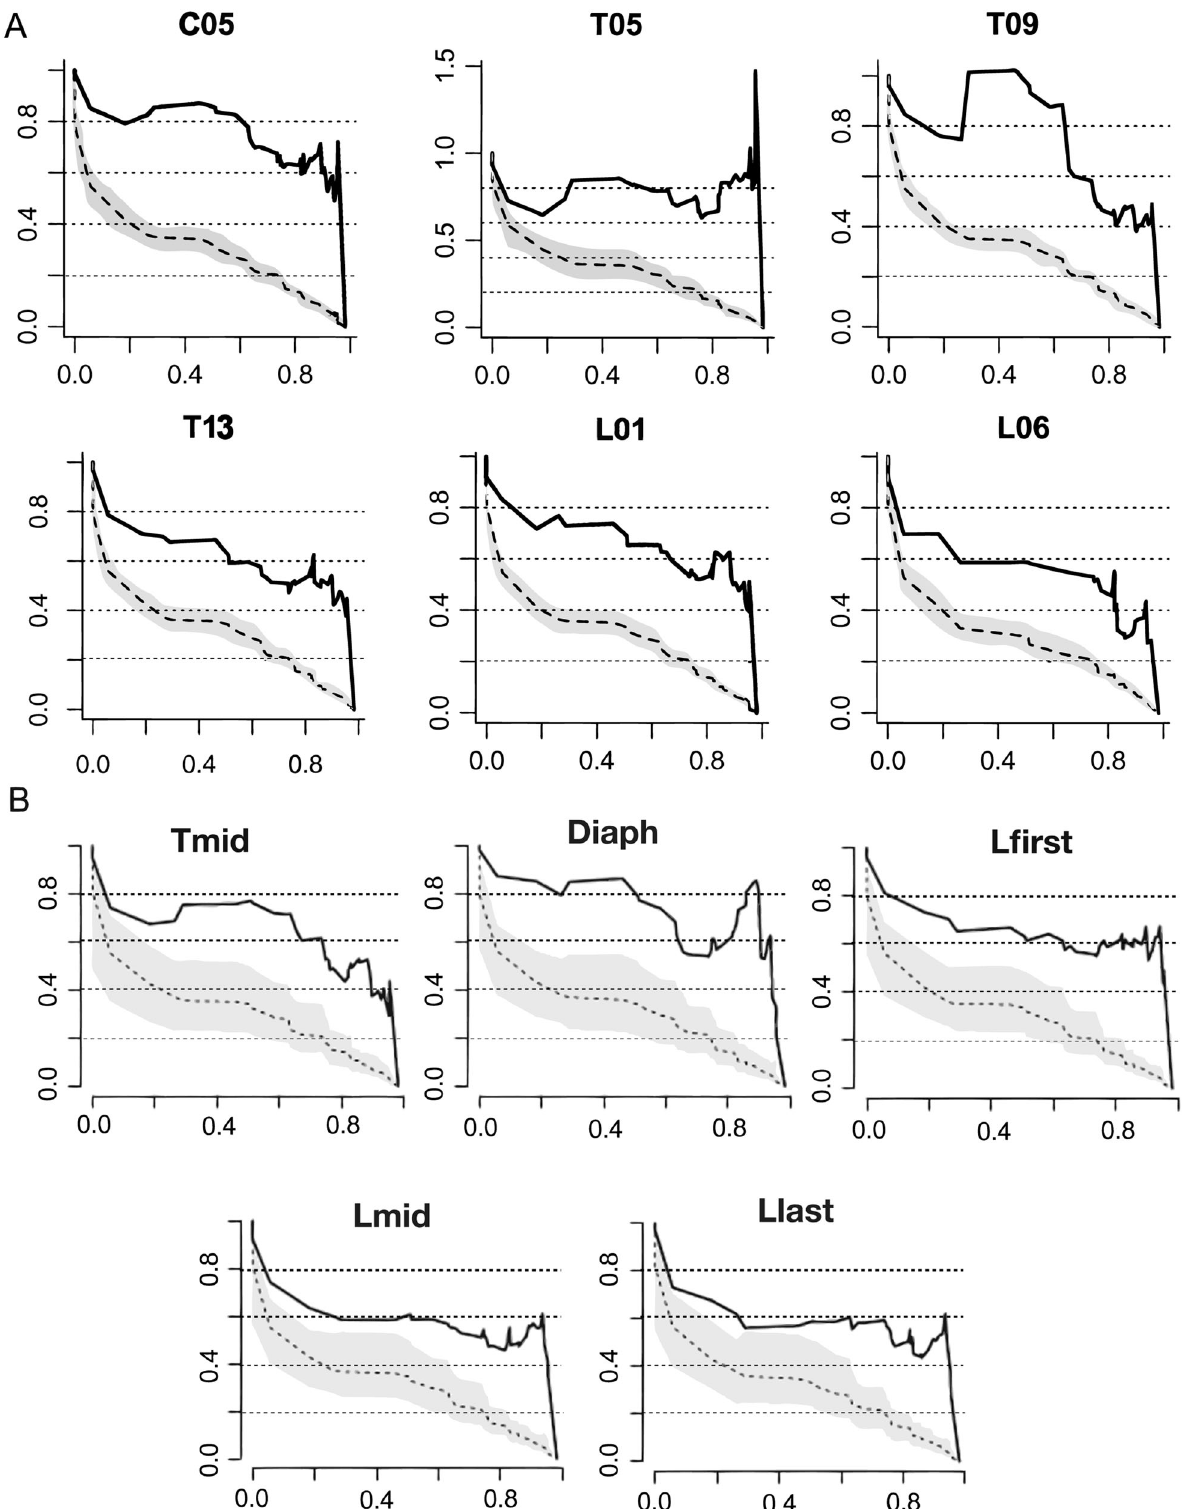
Fig. 4 Disparity through time (DTT) plots for some selected vertebral shape using the residuals from allometric regression. A Results obtained grouping by vertebra for C05,T05, T09,T14, L01 and L06. B Results obtained selecting vertebrae by position for Tmid, Diaph, Lmid and Llast. Note that the results for T fi rst and L fi rst are the same than for T01 and L01 for the analysis grouping by vertebrae. The Y -axis is the average subclade disparity expressed as a proportion of total clade for subclades originating at different times ( X -axis). Relative time values are used with 0.0 representing the root age and 1.0 representing the present. The solid line indicates the mean DTT from the empirical dataset, and the dashed line the simulated datasets. Dashed lines indicate the 95% DTT range (grey) and central tendency (black) for the simulated multivariate data under Brownian motion. For DTT plots of all the vertebrae see Supplementary Figure